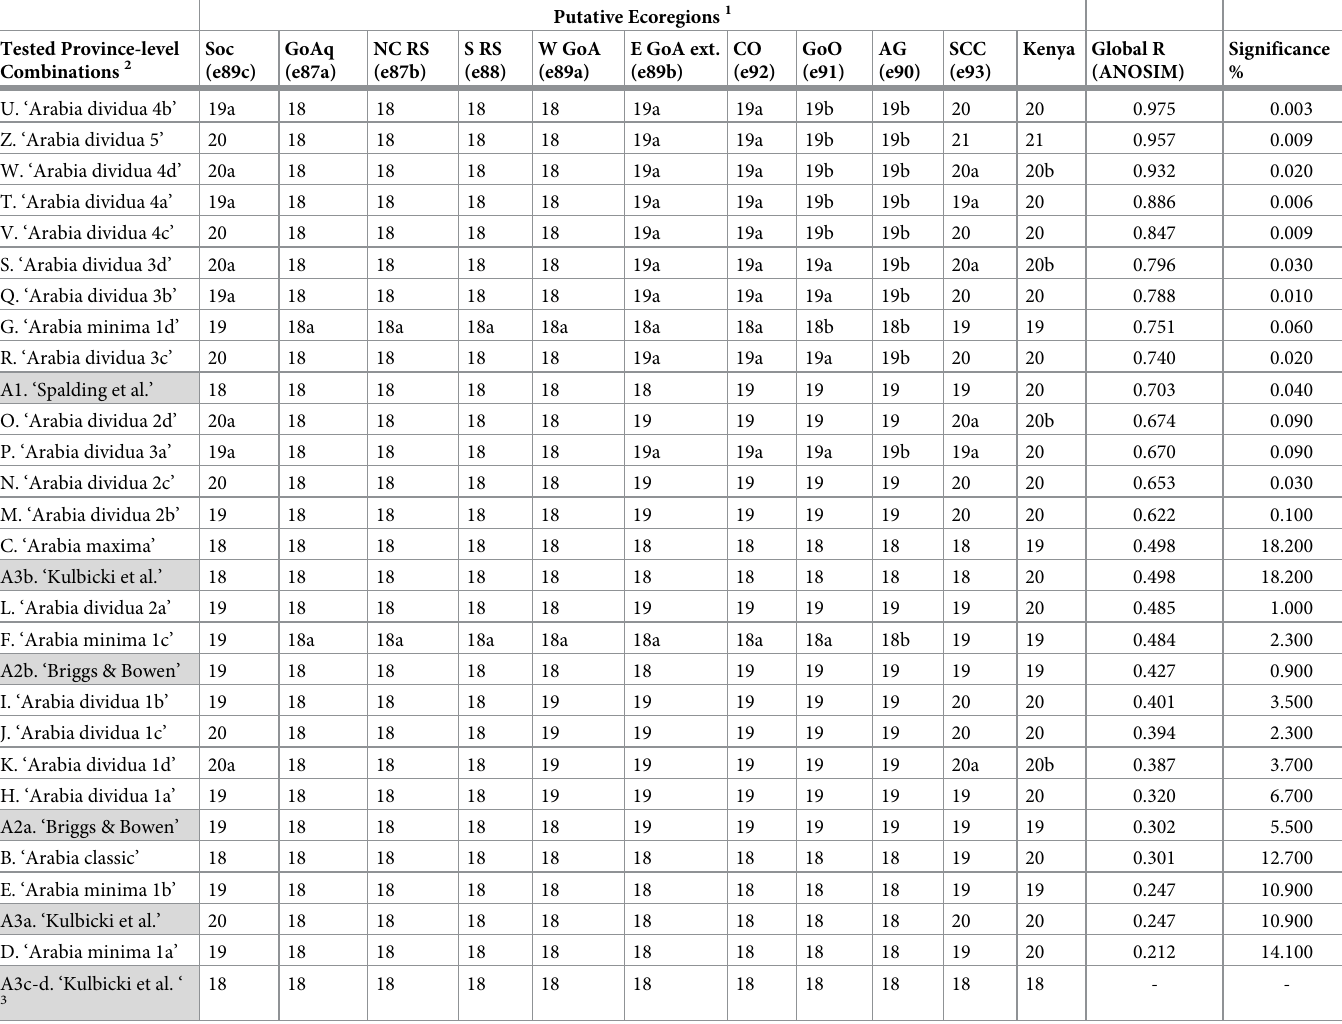
Table 1. List of a priori -defined ‘province-level combinations’ of putative Arabian ecoregions investigated with ANOSIM (based on a resemblance matrix calculated from distributional data of eight key families with Hellinger distance), and Global R and significance results; arranged in order of Global R (including Kenya as comparative outgroup; ‘a’ and ‘b’ coded numbers are computationally separate province-level